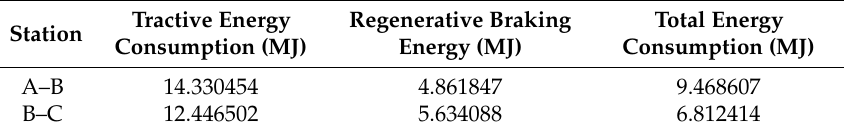
Table 2. Energy consumption of the single